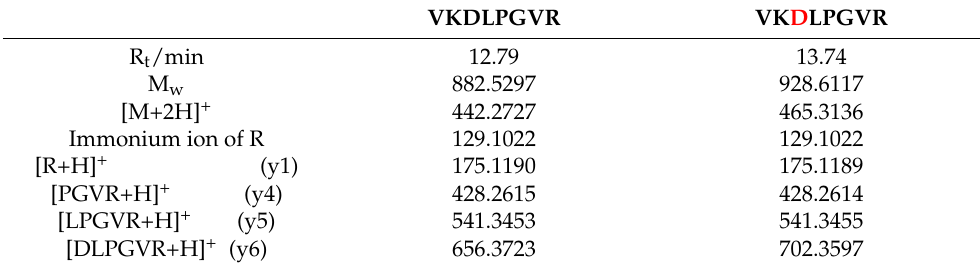
Table 2. Mass spectrometry data of the S12 trypsin peptide containing the D88 (a) .